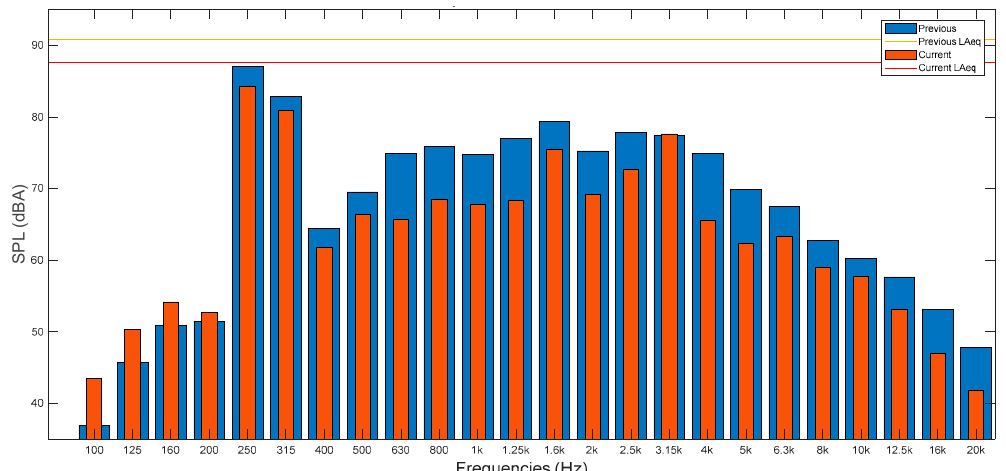
measurements with dBA (A-weighted decibels) weighting.